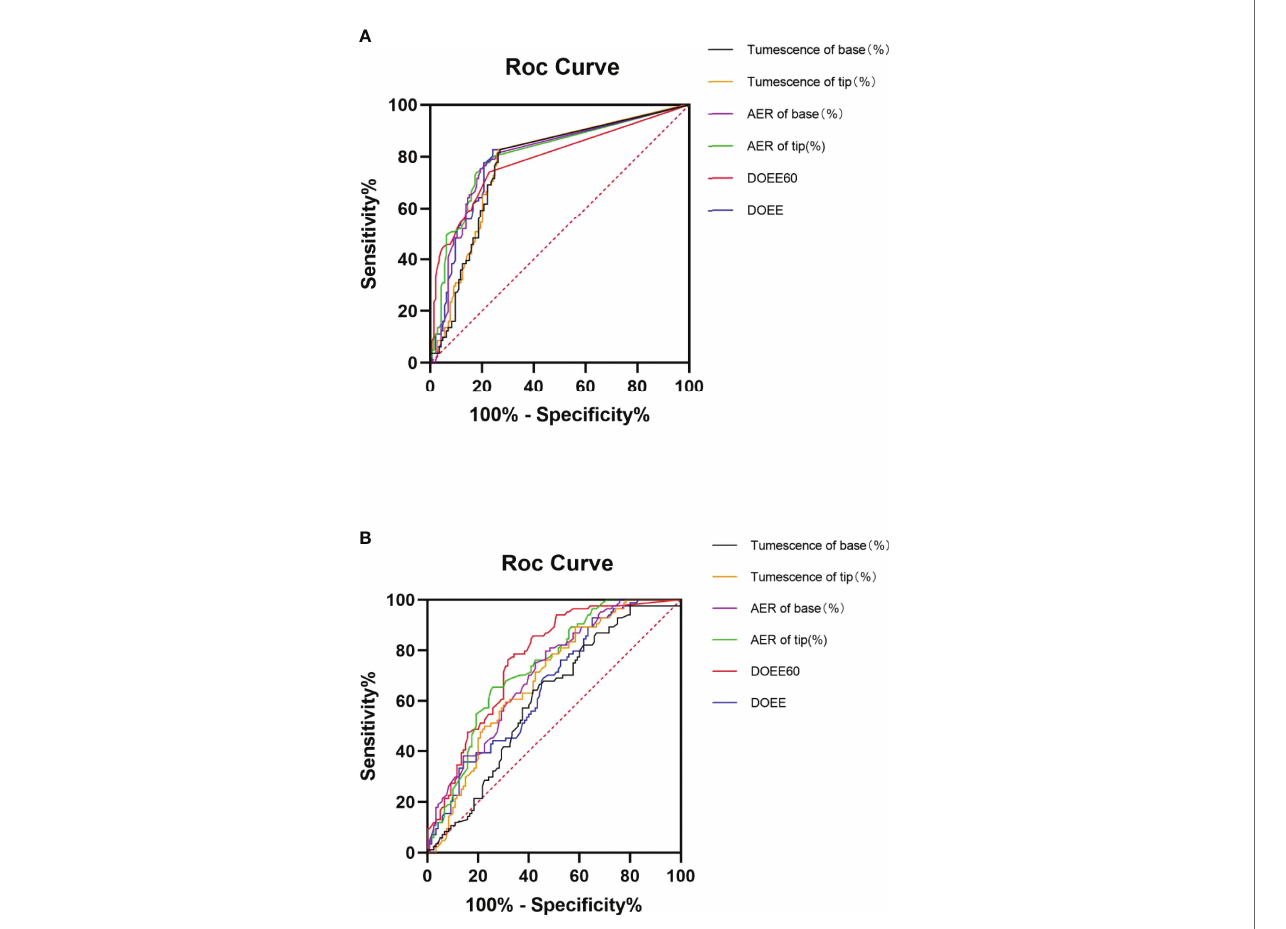
FIGURE 2 | ROC curves of AVSS (A) and NPTR (B) parameters for cured patient prediction. Compared to NPTR parameters, six AVSS measures could reliably predict cured patients after four weeks of daily 5 mg tadala fi l therapy, with signi fi cantly greater accuracy in DOEE and base tumescence in AVSS than other parameters. AER is for average event rigidity; DOEE stands for a duration of erectile episodes; ROC stands for receiver operator characteristic; AVSS stands for audiovisual sexual stimulation, and NPTR stands for nocturnal penile tumescence and